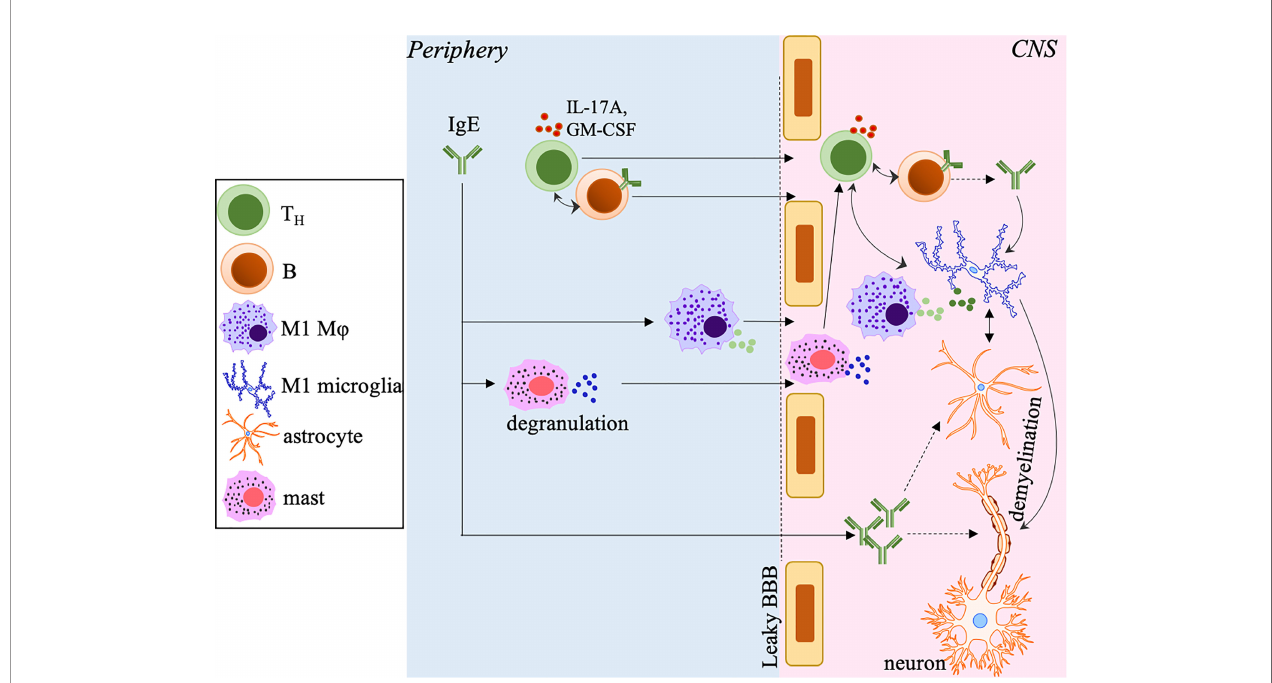
FIGURE 2 | The potential pathogenic role of IgE in MS and EAE. In the periphery, IgE, including myelin-speci fi c or autoreactive IgE, polarizes macrophages toward the M1 phenotype and induces mast cell degranulation, which promotes a leaky BBB allowing increased in fi ltration of T/B-cells, macrophages and mast cells into the CNS. IgE may also penetrate the BBB allowing the deposition into the CNS. In the CNS, IgE activates and polarizes microglia into the M1 phenotype. The M1 microglia and in fi ltrated macrophages produce in fl ammatory mediators to further drive the differentiation of encephalitogenic T H cells, which in turn amplify the M1 polarization of these cells. IgE may directly activate astrocytes that cooperate with microglia to enhance neuroin fl ammation and induce axonal demyelination and destruction. IgE may also potentially directly target oligodendrocytes (not depicted) to promote axonal damage. The accumulation of T H cells and B-cells may form ELSs that perpetuate in fl ammation, demyelination and disease progression. The small circles with different colors close to different cell types represent different secreted in fl ammatory